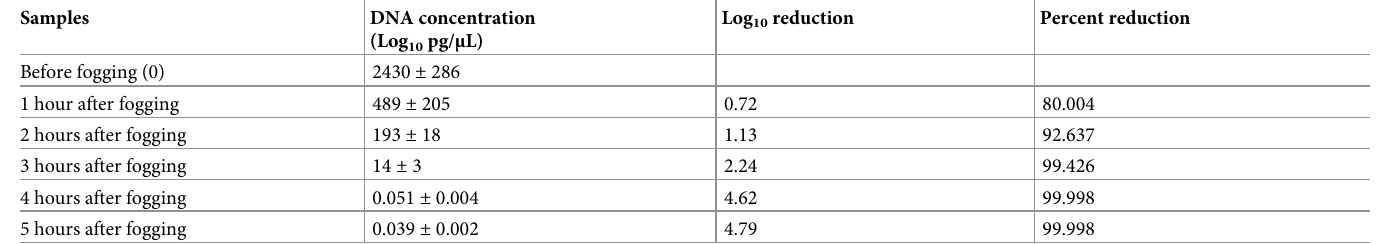
Table 5. Total bacterial load (data reported as mean ± SEM, n = 2), Log 10 and percent reductions before and after Ecas4 anolyte fogging quantified by qPCR using universal bacterial primers and live/dead differentiation.